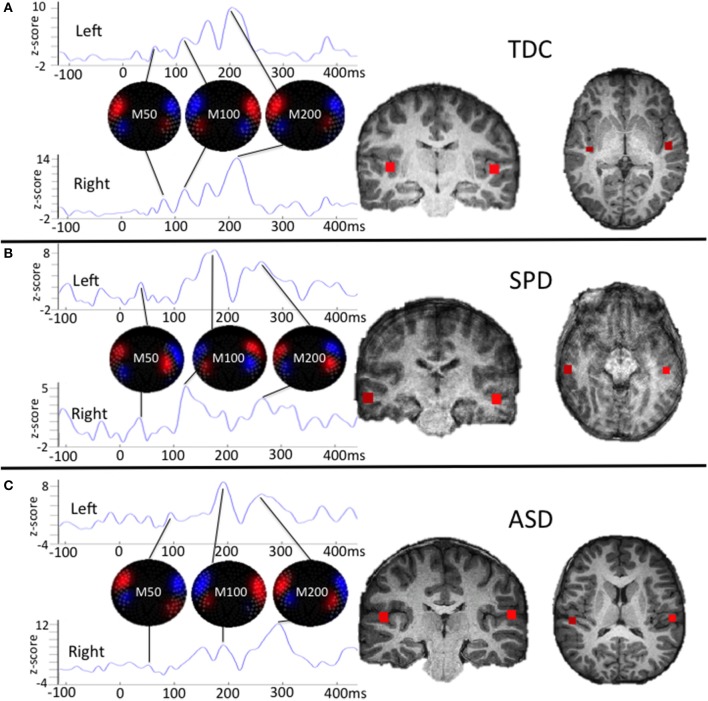
Single participant examples of auditory evoked field source localizations and corresponding waveforms with flux topography for each peak. The waveform amplitude is normalized within subject on the y axis, which represents the z-score of the source waveform amplitude based on the pre-stimulus baseline (originally measured in fT). The timescale on the horizontal axis is in milliseconds. For (A), the chronology of changing flux topography identifies peaks for the M50, M100, and M200 that roughly correspond to their expected latencies in a TDC participant. For (B), the SPD participant demonstrates delays in the right M200 and left M100 and M200 responses. For (C), the ASD participant demonstrates a weak right M50 response and delays for all other responses. This profile of responses for these three participants parallels findings from group level analyses, with the SPD group demonstrating an intermediate phenotype between the auditory evoked responses for the ASD and TDC groups.